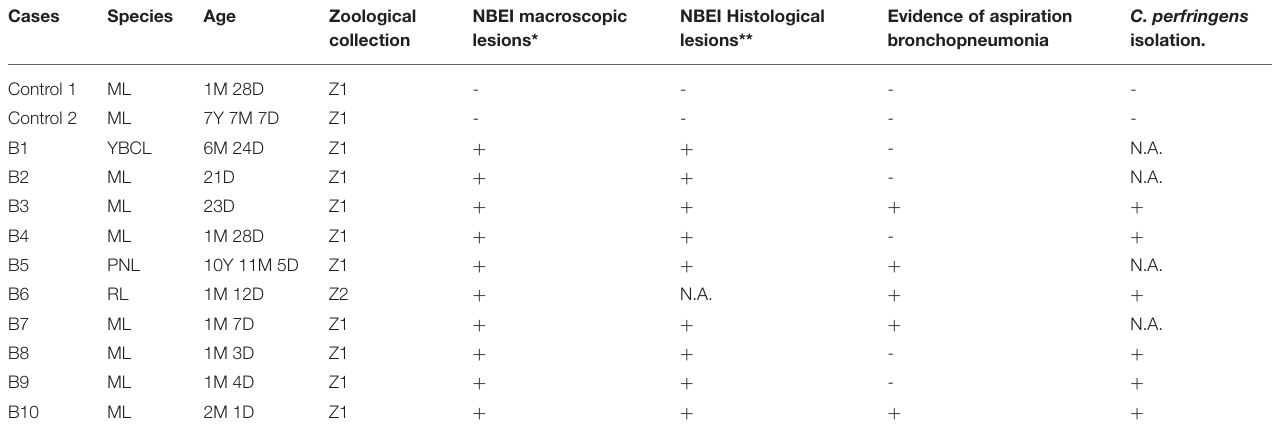
TABLE 1 | Signalment, the presence of macroscopic and histopathological lesions of birds presented with emphysematous ingluvitis and positive/negative detection of C. perfringens .